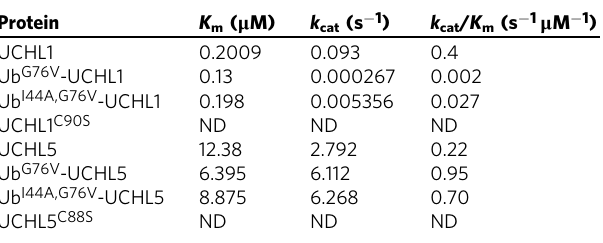
Source data are provided as a Source Data fi